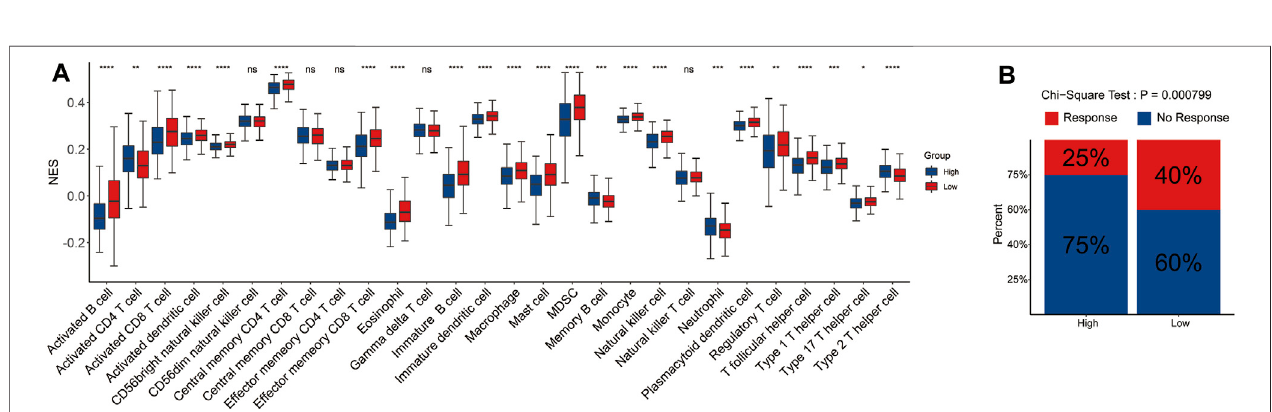
FIGURE6| Correlationbetweentumor-in fi ltratingimmunecellandriskscore.Thein fi ltratinglevelofeachofthe28tumor-in fi ltratingimmunecellsbetweenthehigh- and low-risk groups (A) . The rate of response to immunotherapy between the two risk groups (B) .